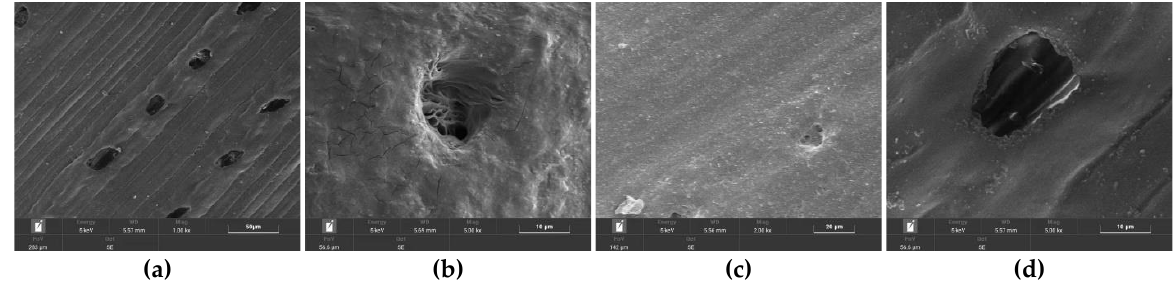
Figure 4. The morphology of fiber surface: ( a ) primitive fiber, ( b ) alkali-treated fiber, ( c ) boiling- water-treated fiber, and ( d ) tap-water-soaked fiber schemes follow the same formatting.